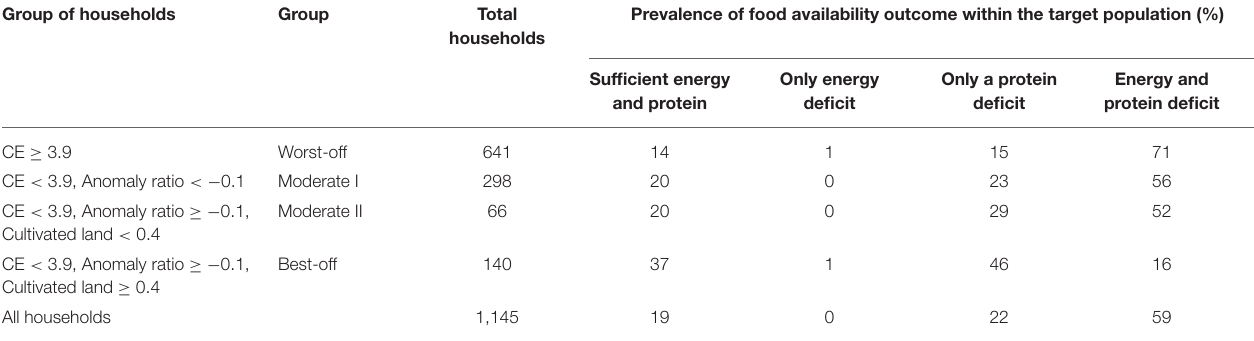
TABLE 3 | Food availability status by target population in Mozambique. Group of